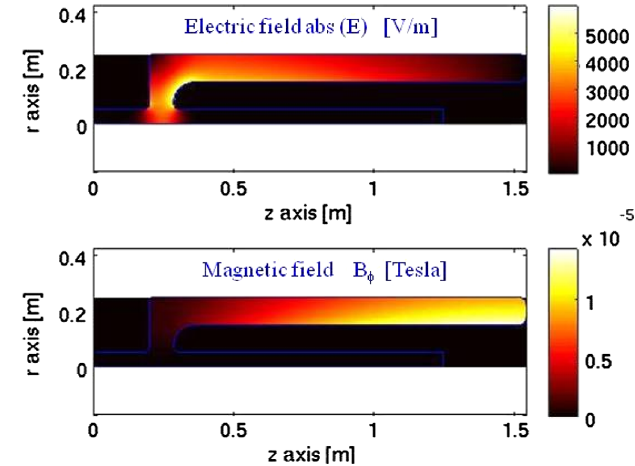
FIG. 4. (Color) Distribution of the electric and magnetic fields in the 56 MHz QWR cavity. This provides a qualitative distribution of the